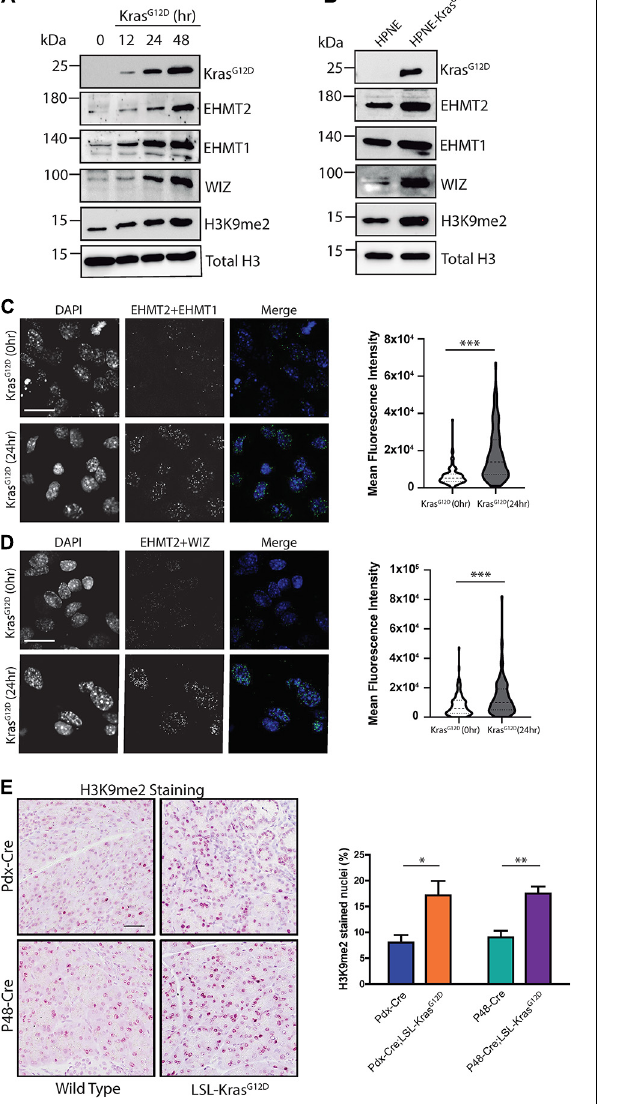
FIGURE 4 | Continued Representative pictures of iKras 4292 cells at 0 and 24 h post-Kras G 12 D induction. Scale = 50 µ M. Right: Violin plot representing MFI of EHMT2/WIZ PLA signal (experiment performed in triplicate). (E) Levels of the EHMT2 product, H3K9me2, as measured by IHC staining. Left: Representative images of pancreas tissue from Pdx1-Cre and P48 Cre / + WT and Kras G 12 D -expressing mice stained for H3K9me2. Scale = 50 µ M. Right: Percentage of nuclei positive for H3K9me2 was quantified from a minimum